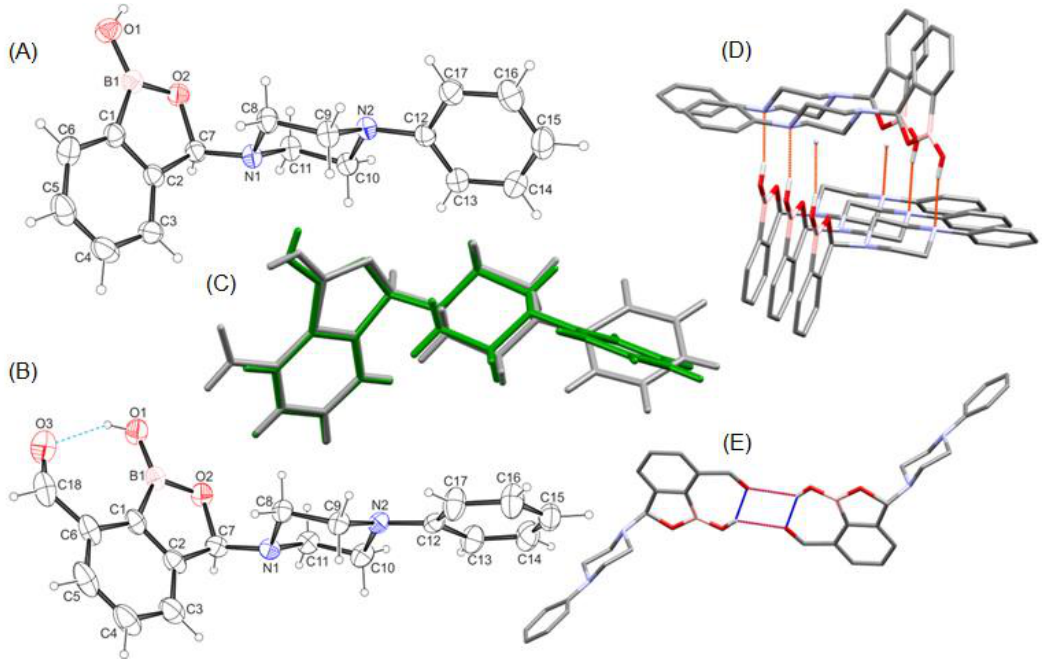
Figure 4. ( A , B ) Ortep drawings [30] of 11 and 14 molecules with atoms numbering scheme, ( C ) Figure4. ( A , B )Ortepdrawings[30]of 11 and 14 moleculeswithatomsnumberingscheme, ( C )Molecules Molecules overlay showing the difference in phenyl ring orientation; ( D ) 1-D supramolecular chain overlay showing the di ff erence in phenyl ring orientation; ( D ) 1-D supramolecular chain formed by formed by molecules of 11 joined by O-H…N hydrogen bonds (in orange); ( E ) Hydrogen-bonded molecules of 11 joined by O-H ... N hydrogen bonds (in orange); ( E ) Hydrogen-bonded dimer of 14 (intra- and intermolecular H-bonds are shown as blue and red lines, respectively. In ( D , E ) hydrogen atoms not involved in hydrogen bonds are omitted for